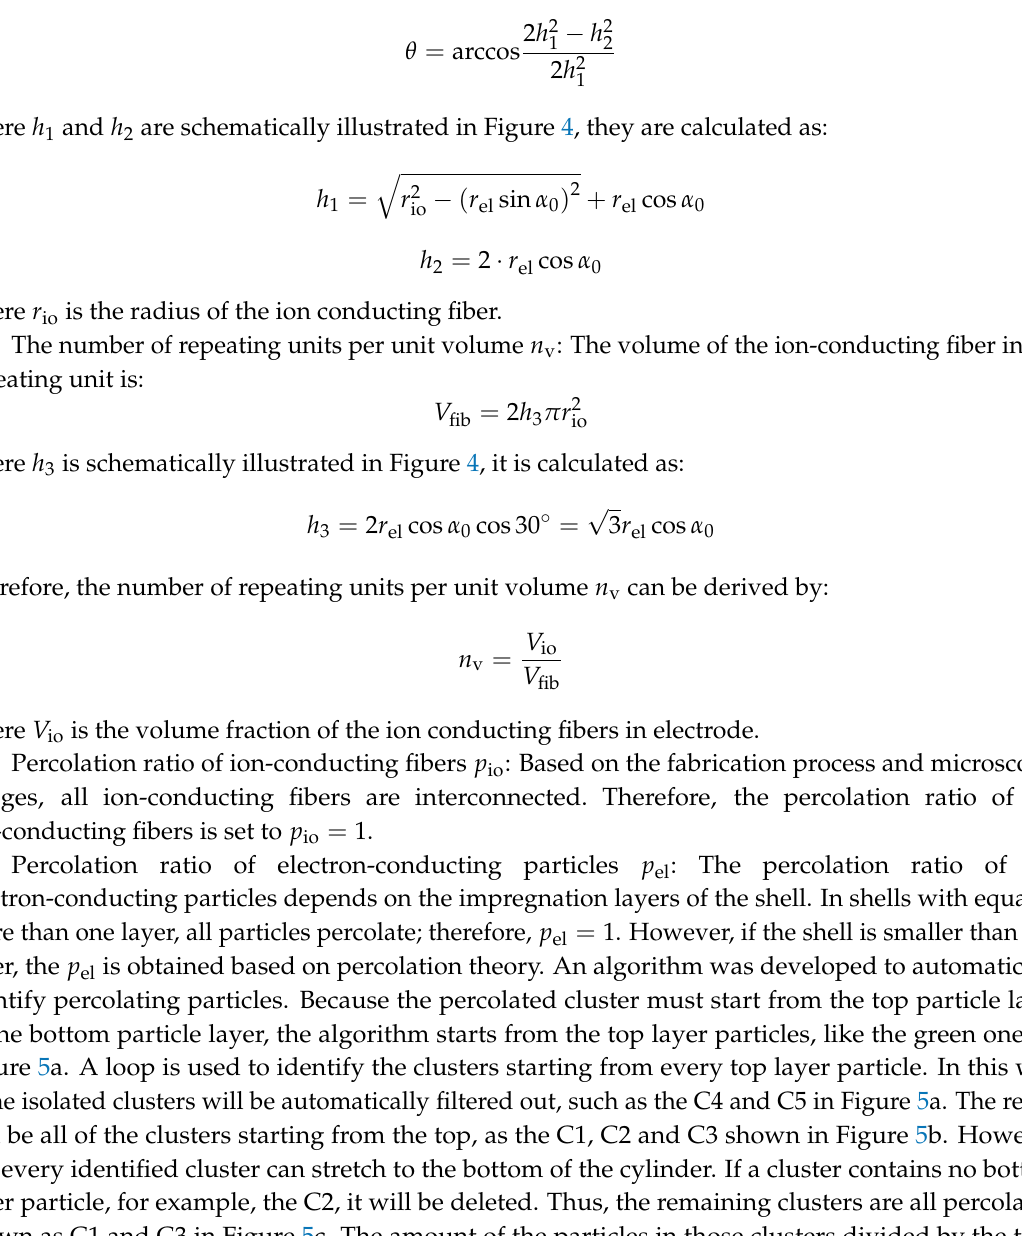
Figure 5. The schematic illustration of the algorithm of p el . ( a ) all of the clusters. ( b ) all of the clusters starting from the top. ( c ) all the percolated clusters.